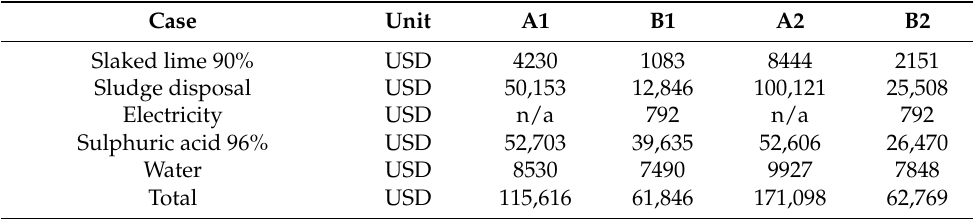
Table 9. Annual expenses for each case of the economic study. (A1) processing 5% H 2 SO 4 wastewater without DD; (B1) processing 5% H 2 SO 4 wastewater with DD; (A2) processing 10% H 2 SO 4 wastewater without DD; (B2) processing 10% H 2 SO 4 wastewater with